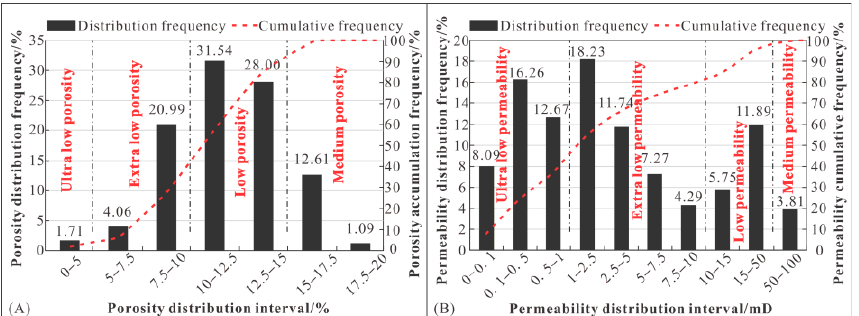
Figure 3. Distribution statistics of the porosity and permeability of the Chang 9 oil formation in the study area. ( A ) Porosity distribution frequency. ( B ) Permeability distribution frequency.